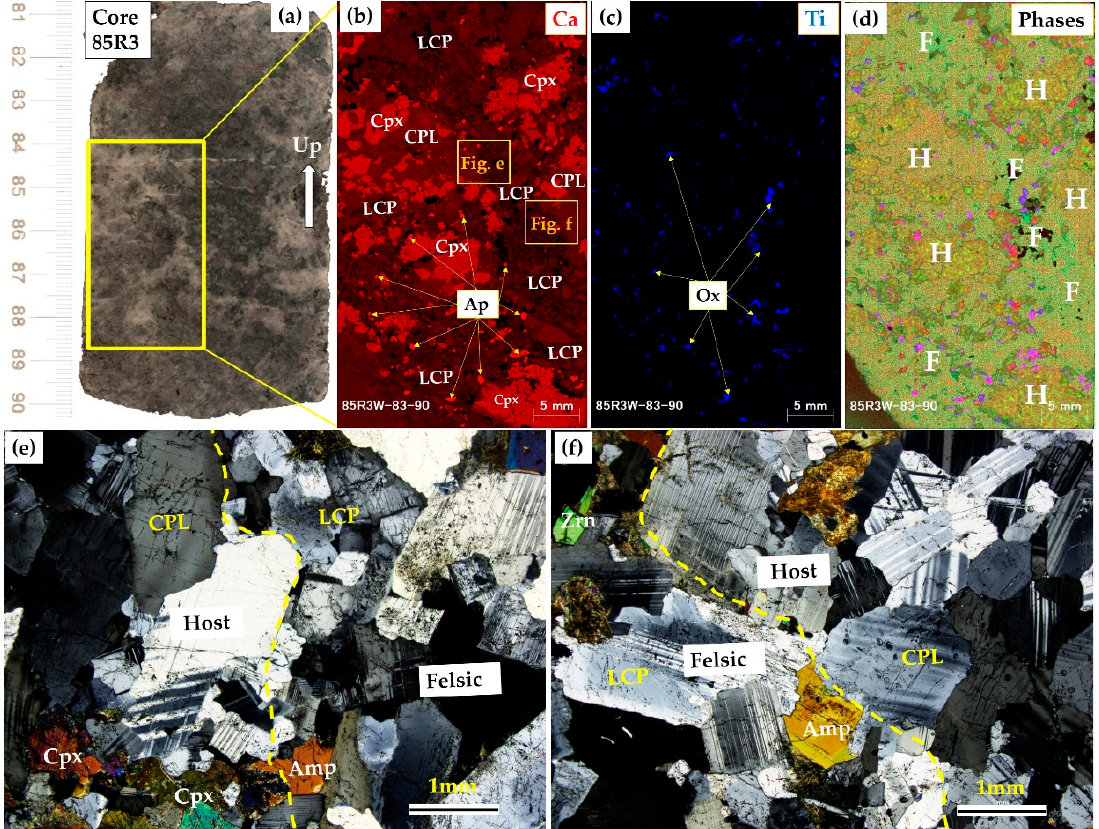
Figure 8. Felsic rock and host oxide bearing gabbro interaction, sample 85R3, 83–90 cm. ( a ) Core scanned photo. ( b – d ) Elemental and phases X-ray mapping images. ( e , f ) Microphotographs of the felsic boundaries. CPL: Calcic plagioclase. LCP: Less calcic plagioclase. Cpx: Clinopyroxene. Ap: Apatite. Ox: Fe–Ti oxide. Zrn: Zircon. H: Host oxide bearing gabbro. F: Felsic part.